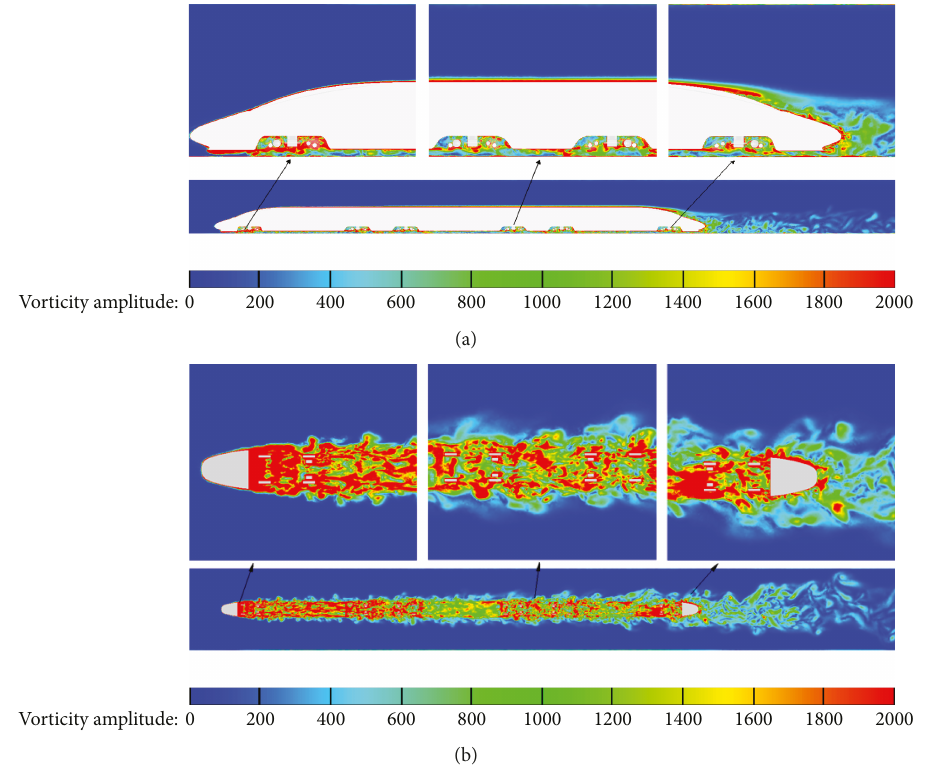
Figure 10: Vorticity amplitude (units: 1/s; free fl ow speed: 83m/s): (a) longitudinal symmetry plane of the train and (b) x - y plane that is 0.1 m above the